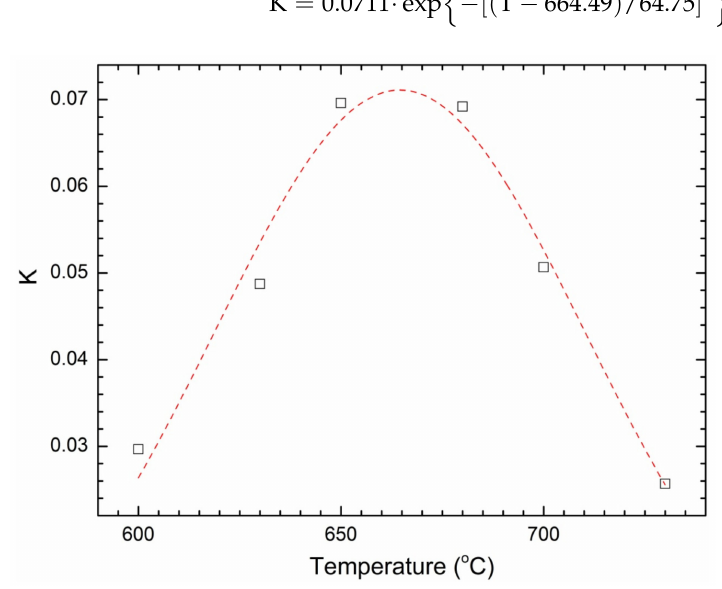
Figure 7. Gaussian Fitting for K to